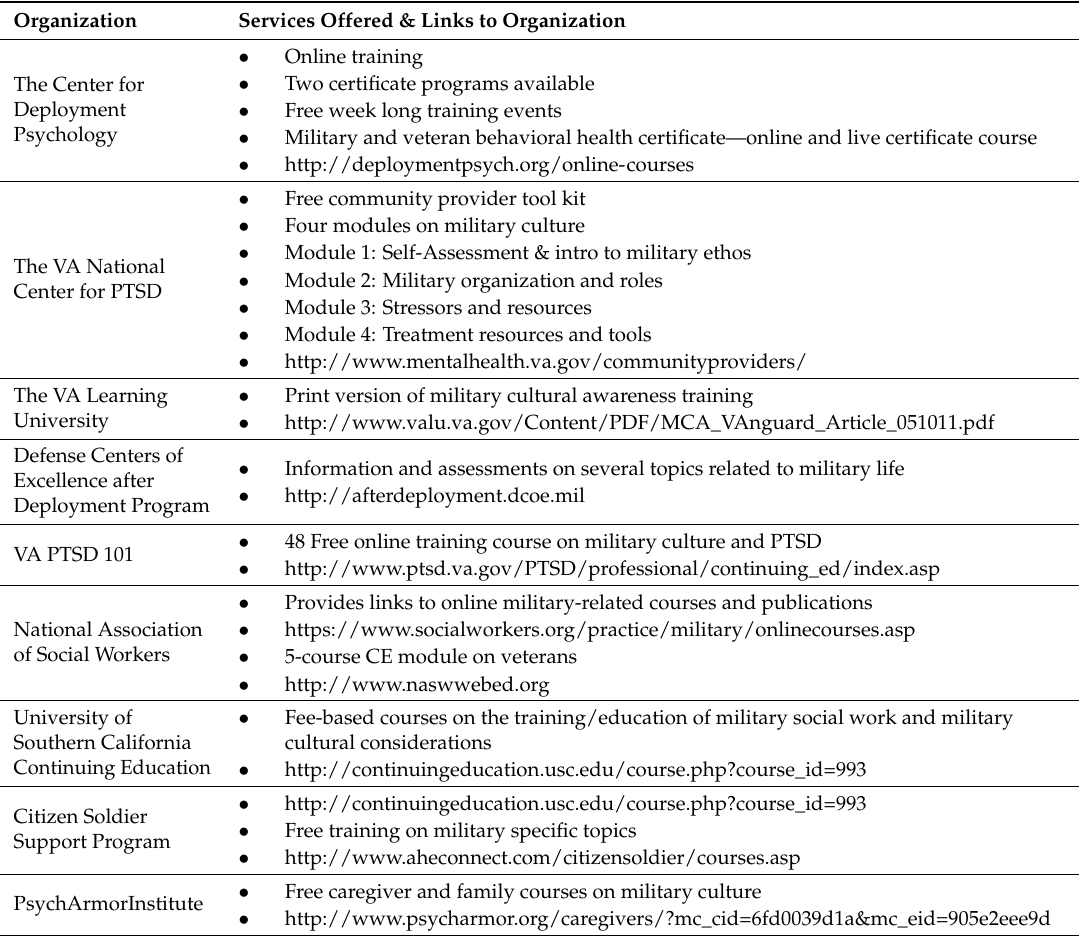
Table A1. Military culture training and awareness